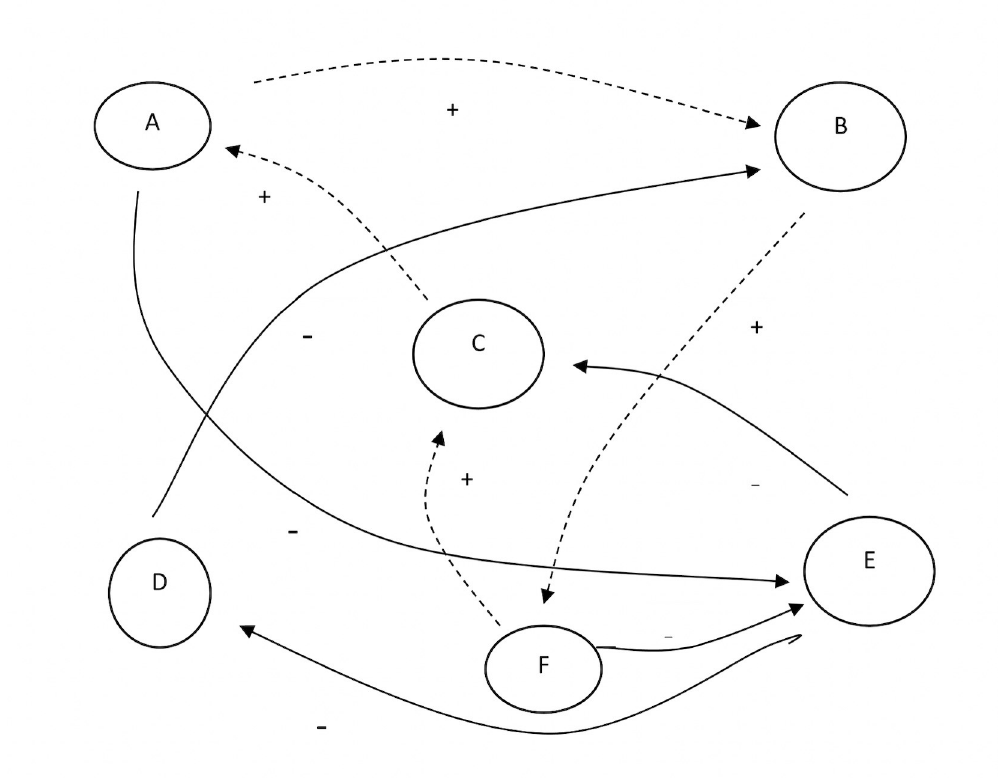
Figure 5. Runaway